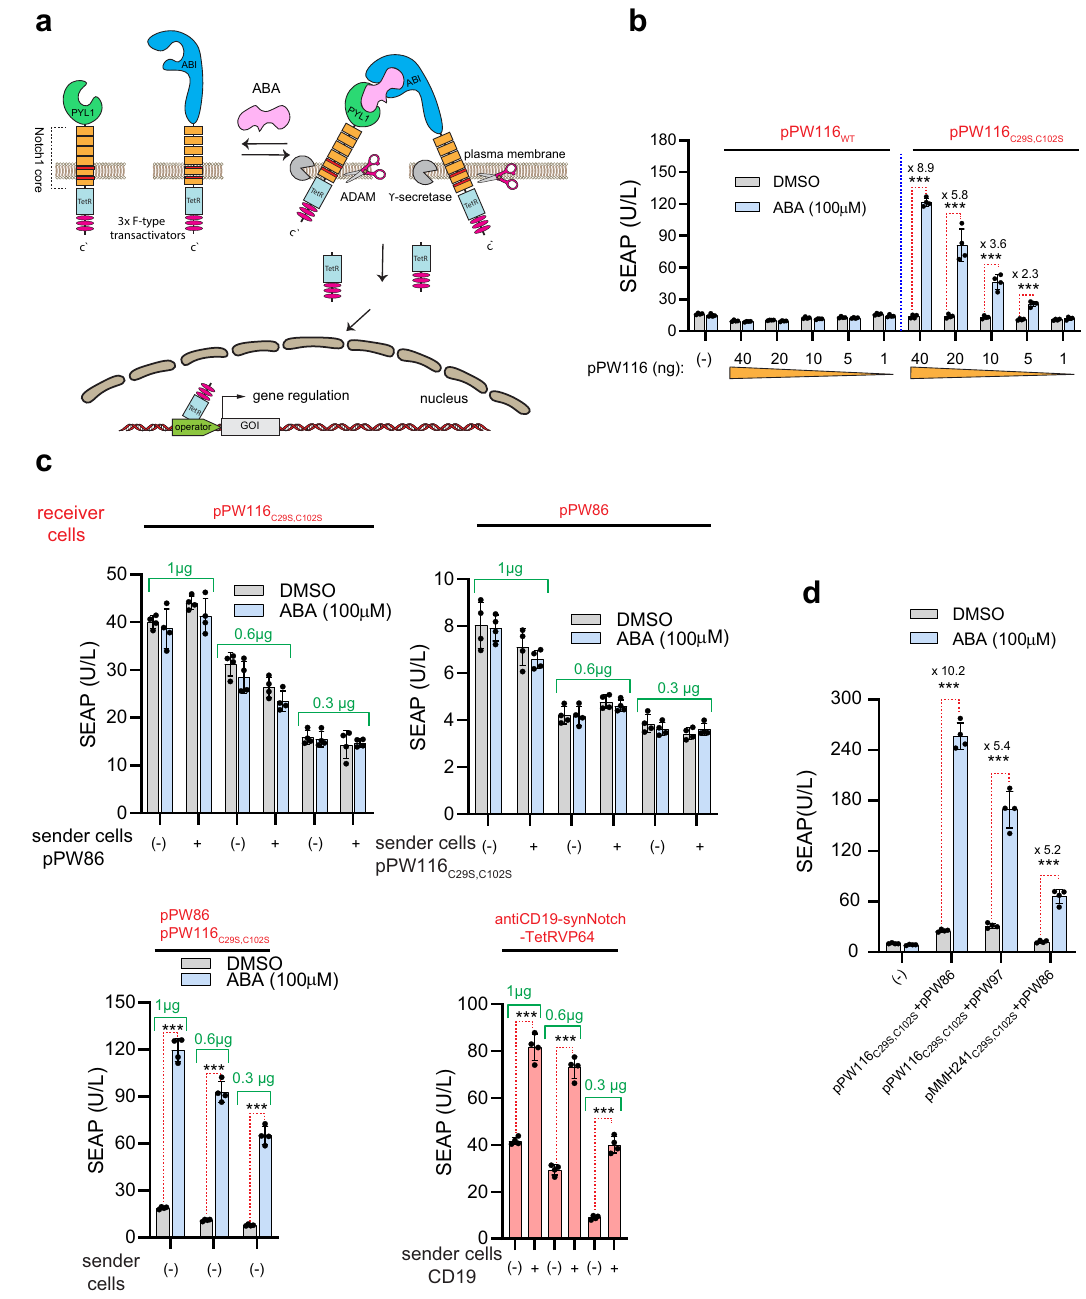
Fig. 4 | Engineering the orthogonal chemically activated receptor (OCAR) platform for selective and orthogonal cell signaling control. a Schematic representation of the ABA-regulated OCAR. b SEAP levels in the supernatants of cells transfected with 40ng pPW86 WT (P PGK -SS-PYL1 WT -Notch1 core -TetR-VP64-pA) and with different amounts of either pPW116 WT (P PGK -SS-ABI WT -Notch1 core -TetR- VP64-pA) or pPW116 C29S,C102S (P PGK -SS-ABI C29S,C102S -Notch1 core -TetR-VP64-pA). All samples were transfected with 20ng of reporter plasmid pTS1017, which encodes to tetO 7 -driven SEAP (O tetO7 -P hCMVmin TetO 7 -SEAP). Data are presented as mean± SD of n =4 biologically independent samples. *** P <0.0001 was calculated using two-tailed, unpaired Student ’ s t -test. c SEAP levels in the supernatants of co- cultured HEK-293 cells. Receiver cells were transfected with different amounts of pPW116 C29S,C102S and pPW86 WT either separately or in combination. Similar trans- fection procedure was performed using anti-CD19-synNotch-TetR-VP64. All recei- ver cells were co-transfected with the reporter plasmid pTS1017 (see methods).